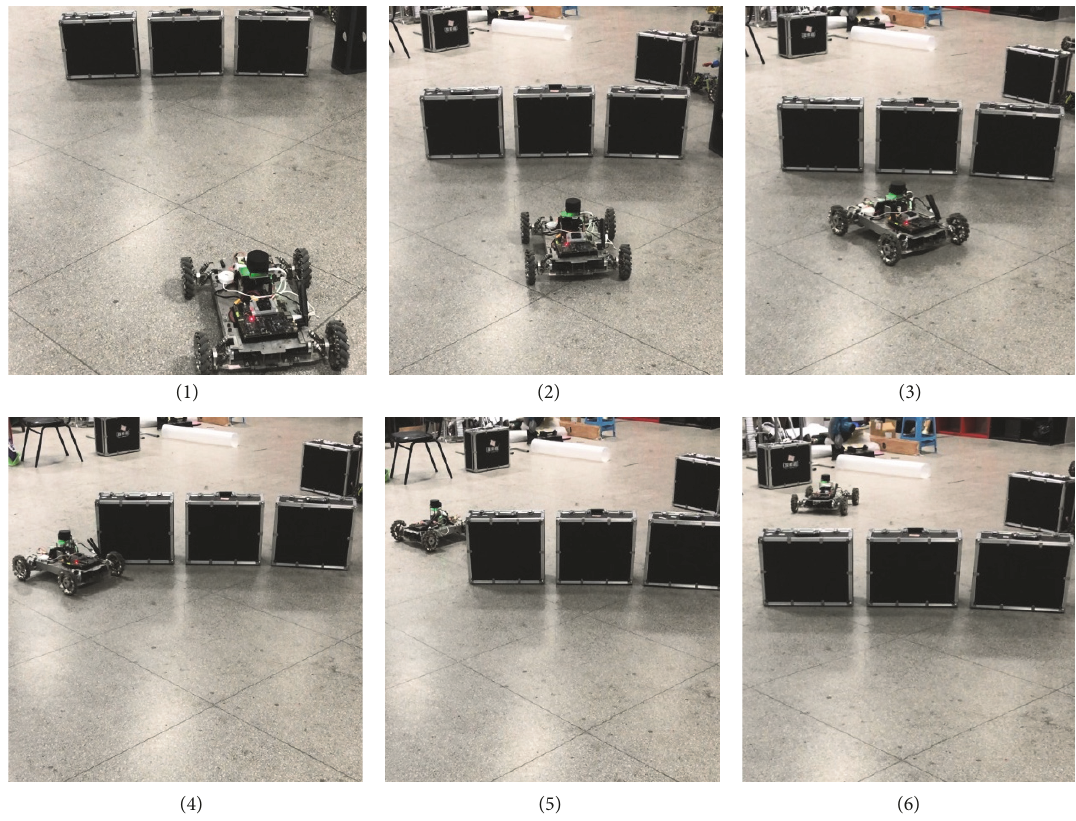
Figure 11: The movements of the agent in actual